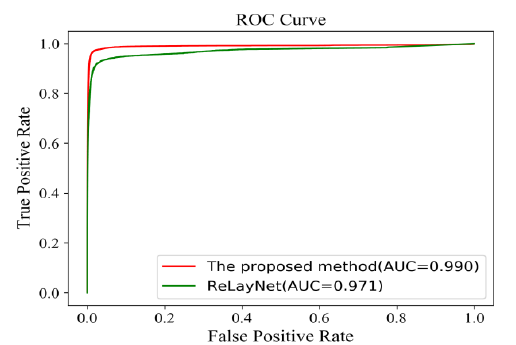
Figure 15. Comparison of ROC curves.